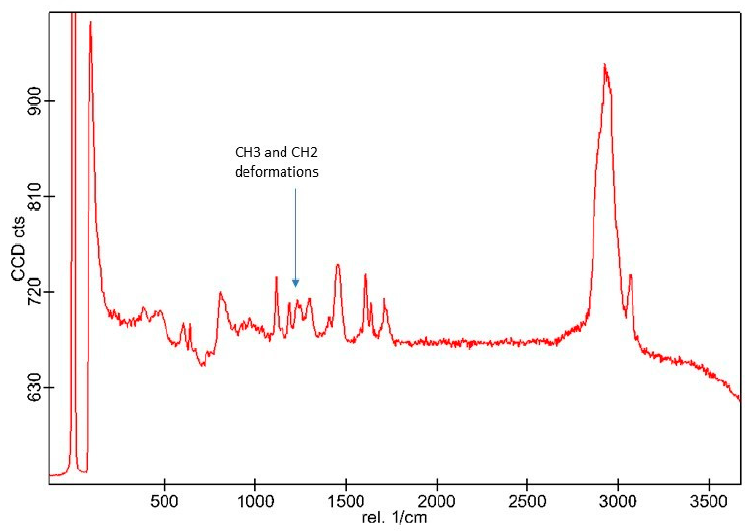
Figure 5. CH3 and –CH2 deformations within the EA are represented by peaks between 1410 and 1460 cm − 1 . Table 1. Showing µ TBS of two groups post various conditioning protocols.